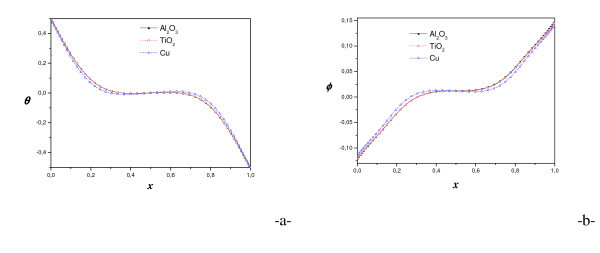
Temperature (a) and concentration (b) on the horizontal mid-plan (RT = 104, φ = 2%, Le = 3 and Sr = 2%).